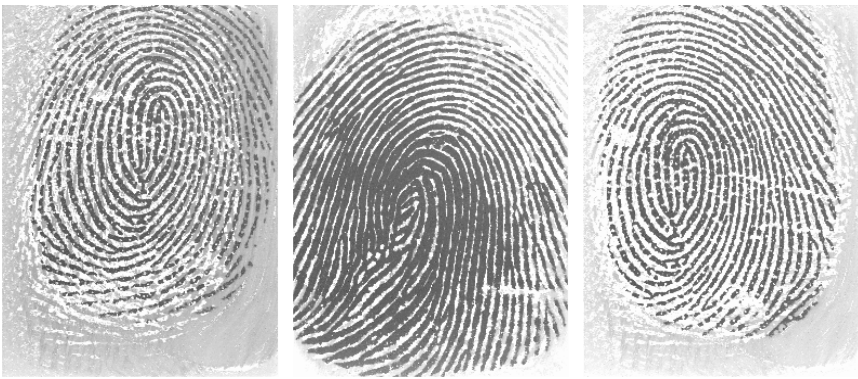
Figure 8. Examples of the residue images captured by optical